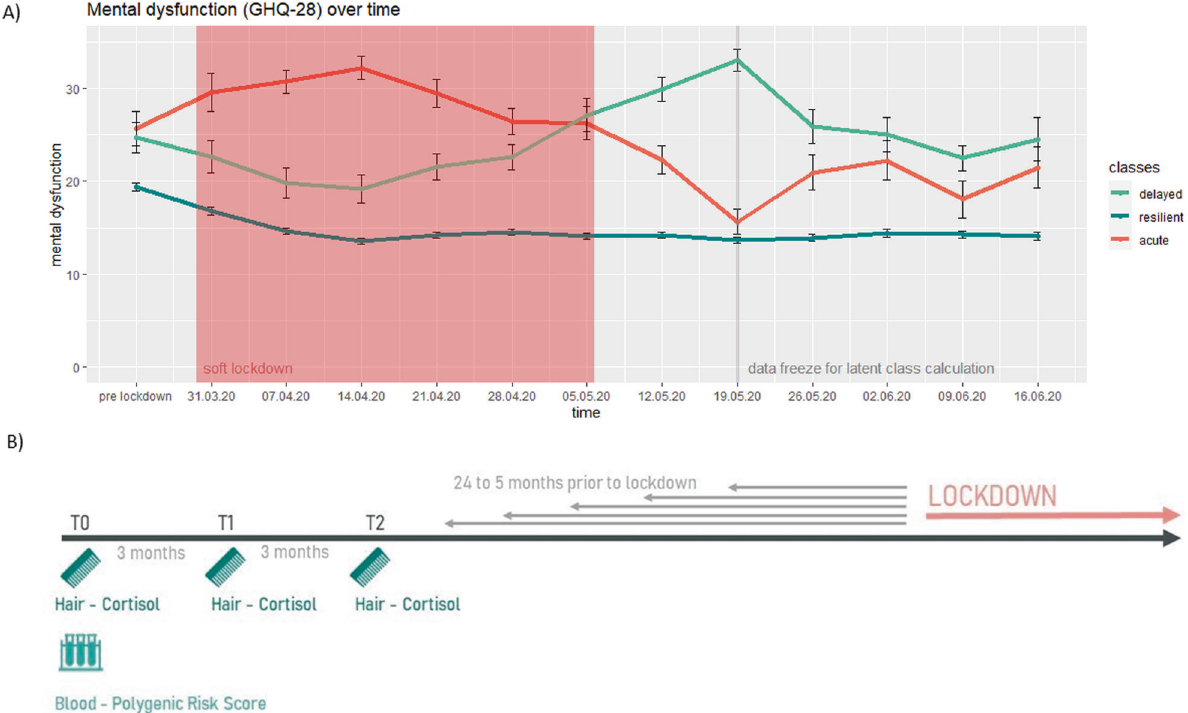
Fig. 1 Mental health trajectories and study design. A Mental dysfunction of different mental health trajectories over time. Red area represents “ soft ” lockdown in Germany, with comparatively mild measures to restrict social contact. Calculation of latent class membership was based on their most likely latent class membership on the pre lockdown mental dysfunction value and the mental dysfunction values during the fi rst 8 weeks of lockdown: “ acute dysfunction ” class = 9.0% ( n = 47), “ resilient ” class = 82.6% ( n = 432), “ delayed dysfunction ” class = 8.4% ( n = 44) [7]. B Study design – bio samples collected at baseline, T1, and T1 of LORA study. Groups with different mental health trajectories were calculated based on weekly online surveys during the COVID lockdown in Participants Detailed inclusion criteria are described in the Supplement. Of the 523 participants who took part in the COVID surveys (for detailed descriptive analyses, see Ahrens et al. [7]), hair cortisol analyses were available from n = 192 participants. Genetic analyses were obtained from n = 364 participants, and for n = 142, both hair cortisol and genetic analyses were available. The descriptive demographic statistics for the three groups in the hair cortisol and the PRS datasets are shown in Tables 1 – 2, the descriptive demographic statistics for the complete dataset are shown in Supplementary Table 1. All participants provided written informed consent. The study meets the terms with the Code of Ethics of the World Medical Association (Declaration of Helsinki; Rickham, 2013) and was accepted by the respective Ethics Committees in Frankfurt am Main (registration number: 244/16) and Mainz (registration number: 837.105.16(10424)), Germany. Polygenic risk score calculation DNA from blood was collected from the original LORA study at baseline assessments and was used to perform Polygenic Risk Score calculations for participants from the LORA-COVID subsample. To calculate a PRS, the amount of trait-associated alleles in individuals are weighted by per-allele effect sizes derived from previously published large GWAS and normalized by a relevant population distribution [47]. Therefore, genotyping of the LORA study participants was performed in n = 959 participants, using an using PLINK v1.9 [48]. The SNPs were fi ltered applying the following quality control criteria: minor allele frequency ≤ 0.01, not uniquely mappable or tri- missingness > 0.02, and sex mismatch were excluded from our study. Participants with a cryptic relationship with a pi-HAT > 0.2 were excluded. Filtering for population structure and criteria was performed using the following criteria: HWE p < 0.02, missingness = 0, MAF > 0.2, and a pruned